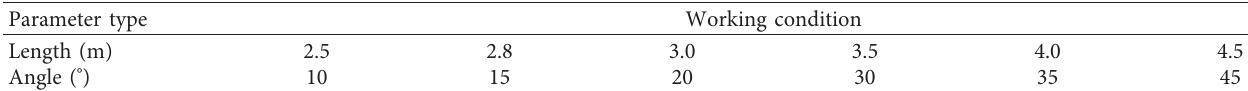
Table 3: Working conditions of the locking foot anchor.